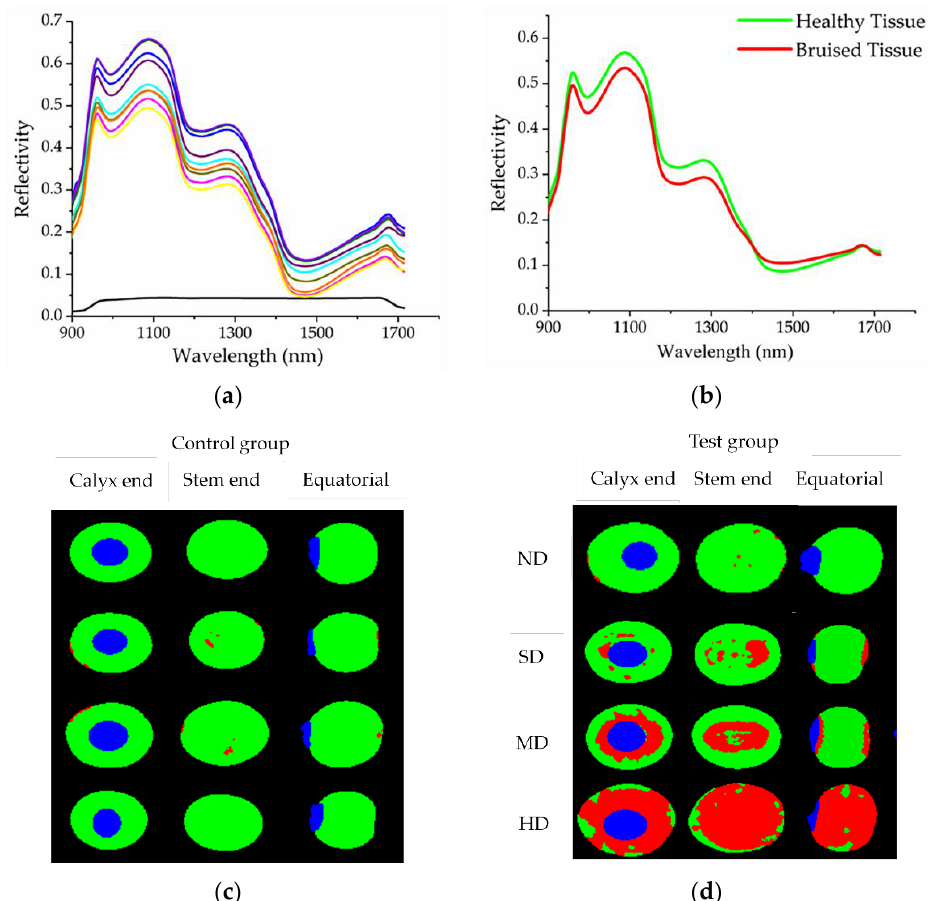
Figure 5. Spectral curve image of blueberries and hyperspectral classification image of each damage stage. The spectral curves of blueberries and background plate ( a ), the black curve is the background plate and the other color curves are the different positions on the blueberry fruit. The spectral curves of blueberry healthy tissue and damaged tissue ( b ). Hyperspectral classification images of the control group ( c ) and test group ( d